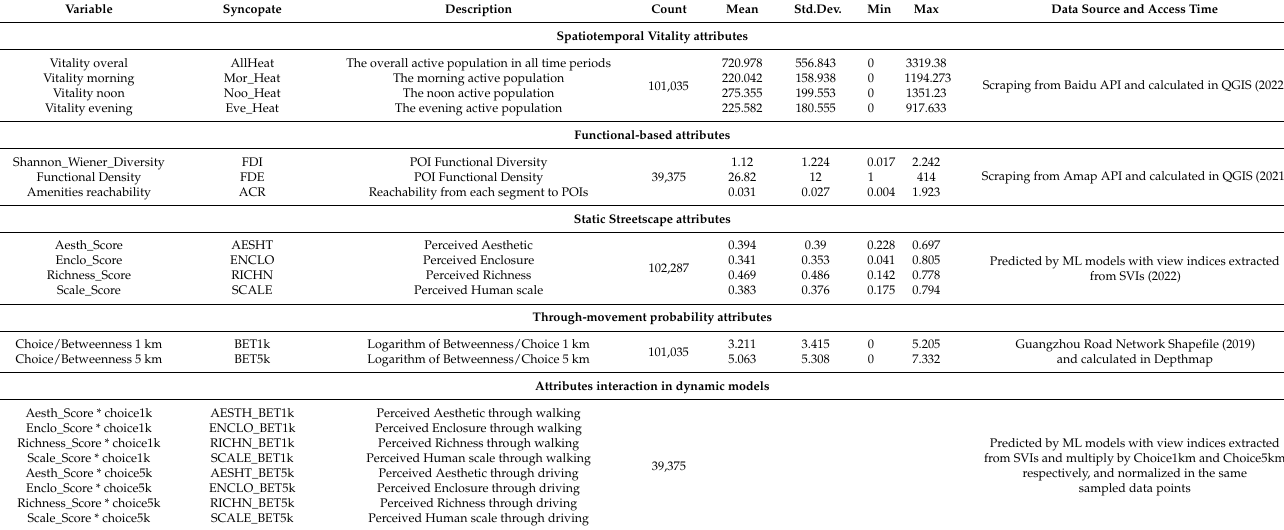
Table 1. Descriptive statistics of all